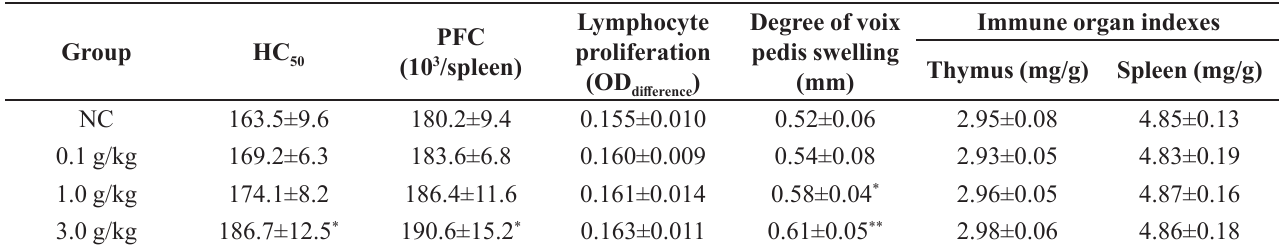
TABLE II - Effects of OR on hemolytic activity, antibody-producing cells, lymphocyte proliferation, delayed-type hypersensitivity response, and immune organ indices in mice Group